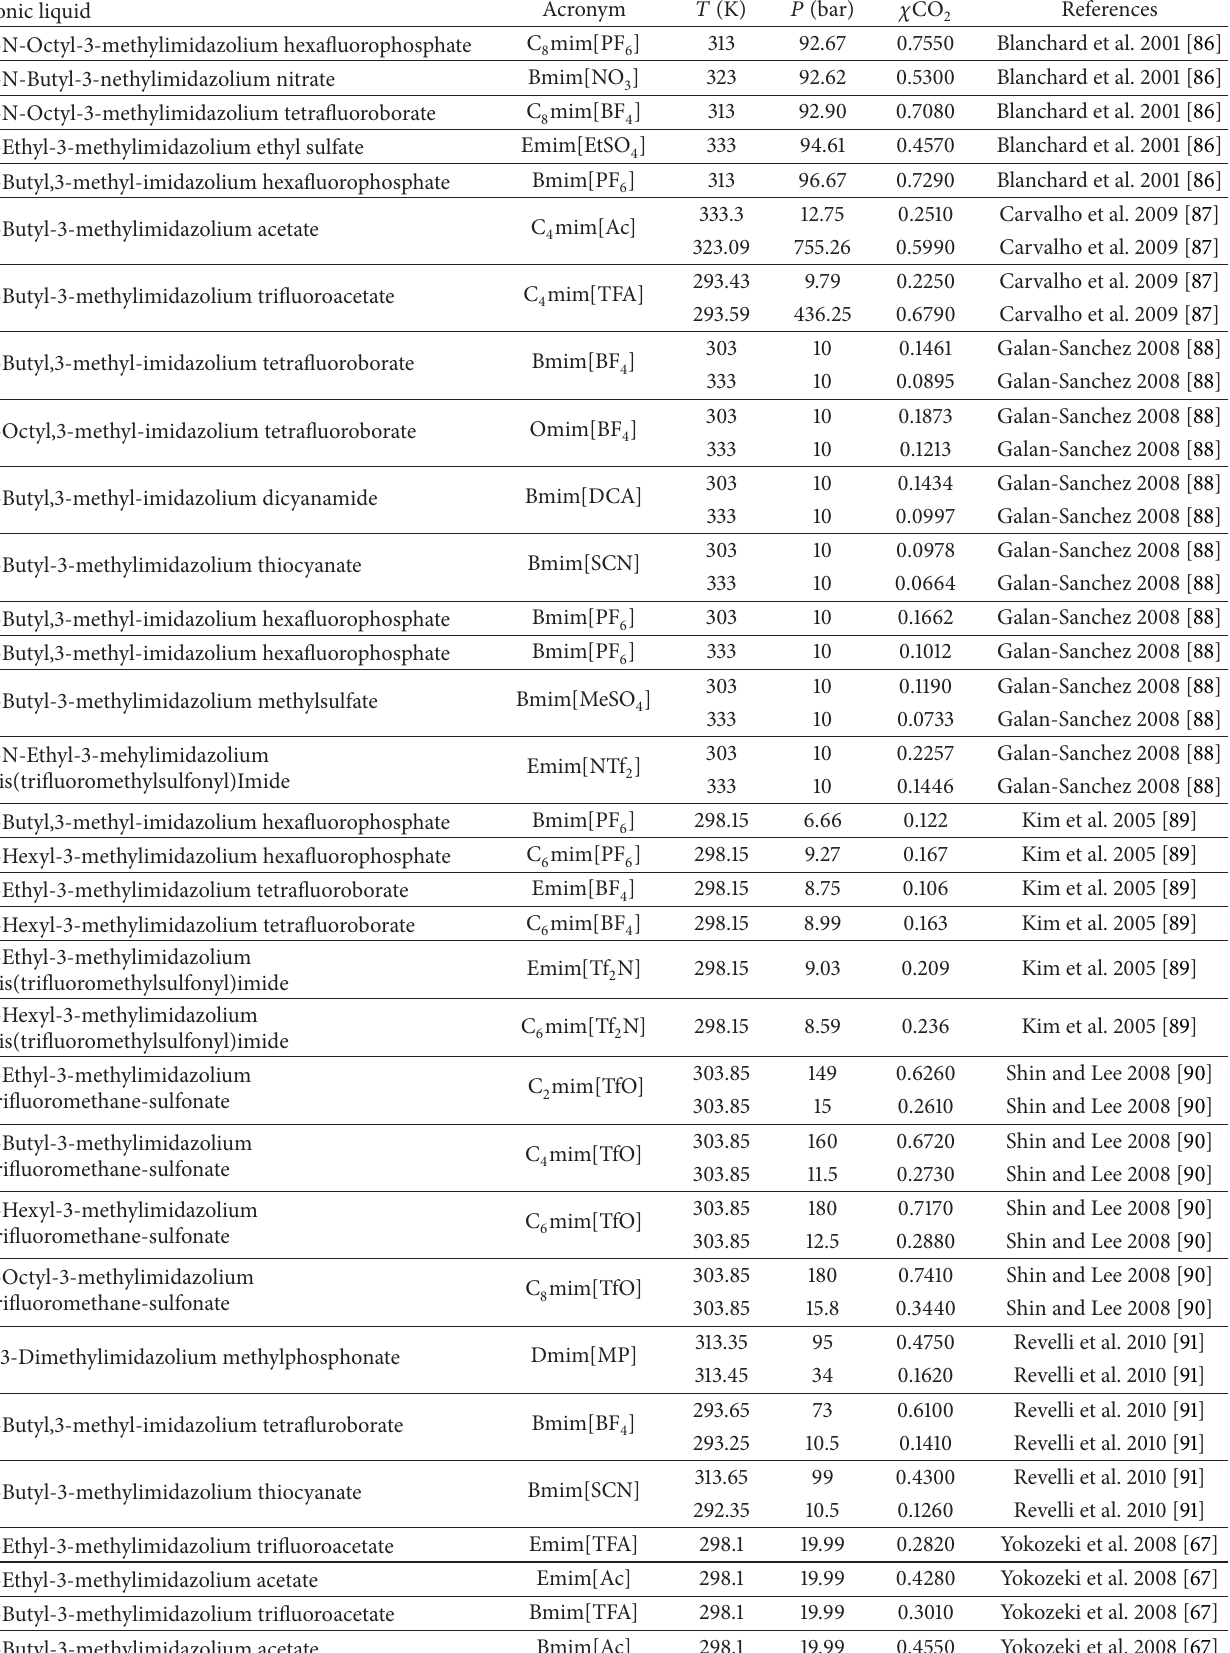
Table 4: CO solubility data for imidazolium-based ionic 2